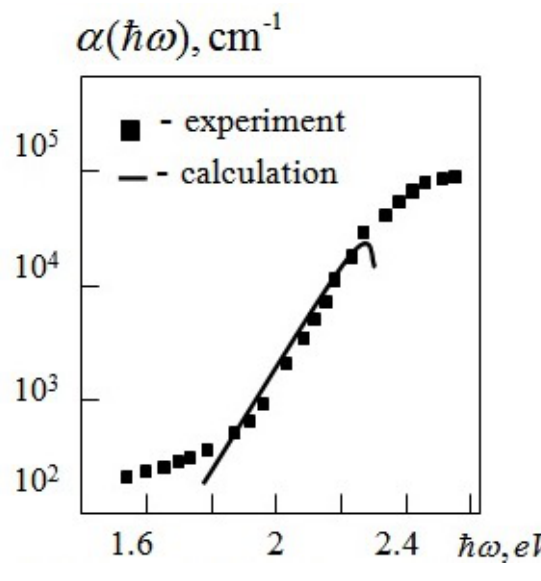
Fig. 2. Exponential absorption spectra of amorphous Se 0.5 S 0.5 obtained from the experiment and from the calculation of formula (8) a is the region of fundamental absorption, b is the region of exponential absorption, c is the region of defective absorption.